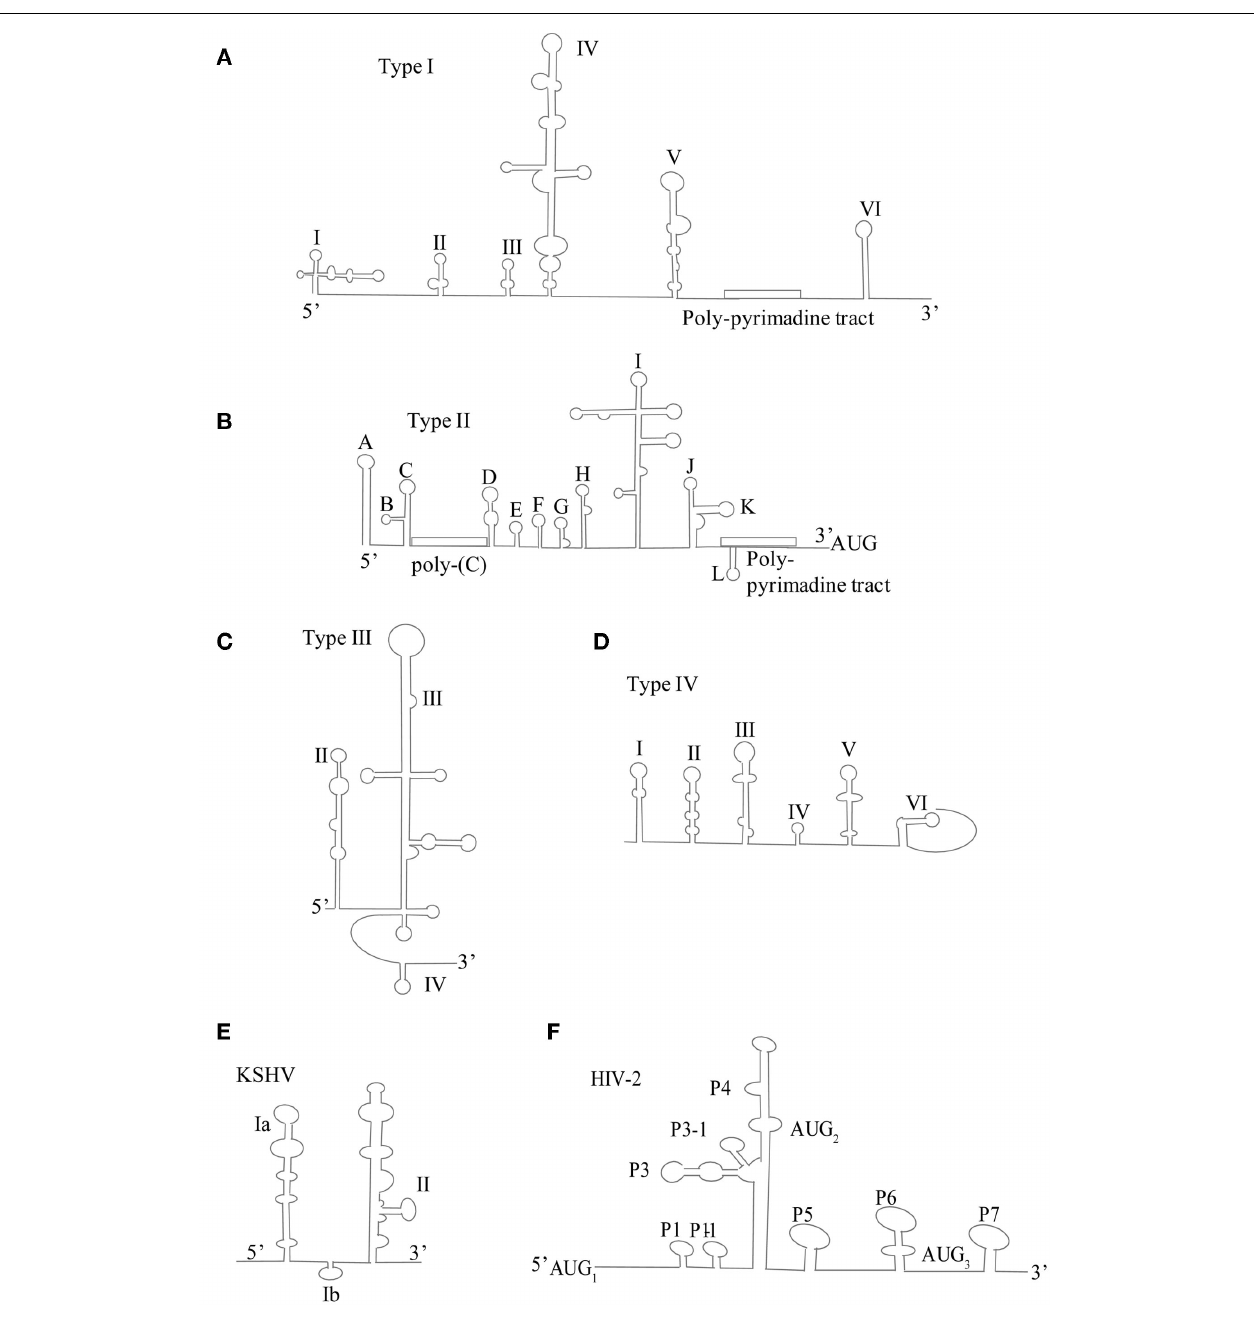
FIGURE 1 | Schematic of proposed secondary structure of viral IRESs. (A) Type I IRES represented by PV-1 (adapted from Jang, 2006) (B) Type II IRES represented by EMCV (adapted from Jang, 2006) (C) Type III IRES represented by HCV (adapted from Beales et al., 2003 (D) Type IV IRES